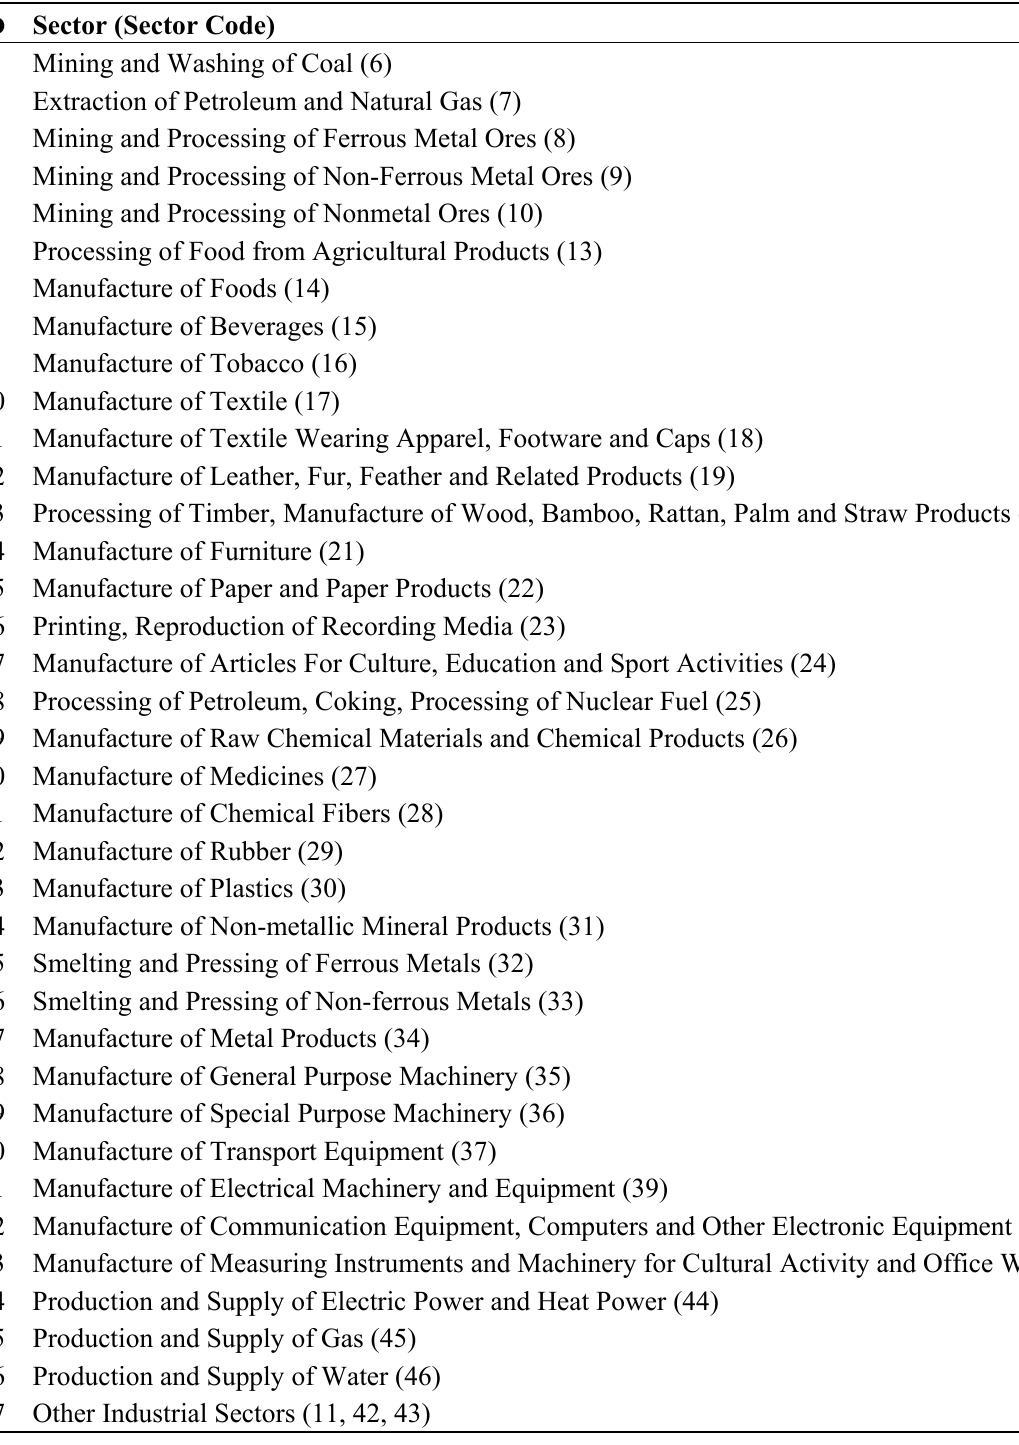
Table 1. Industrial sectors of